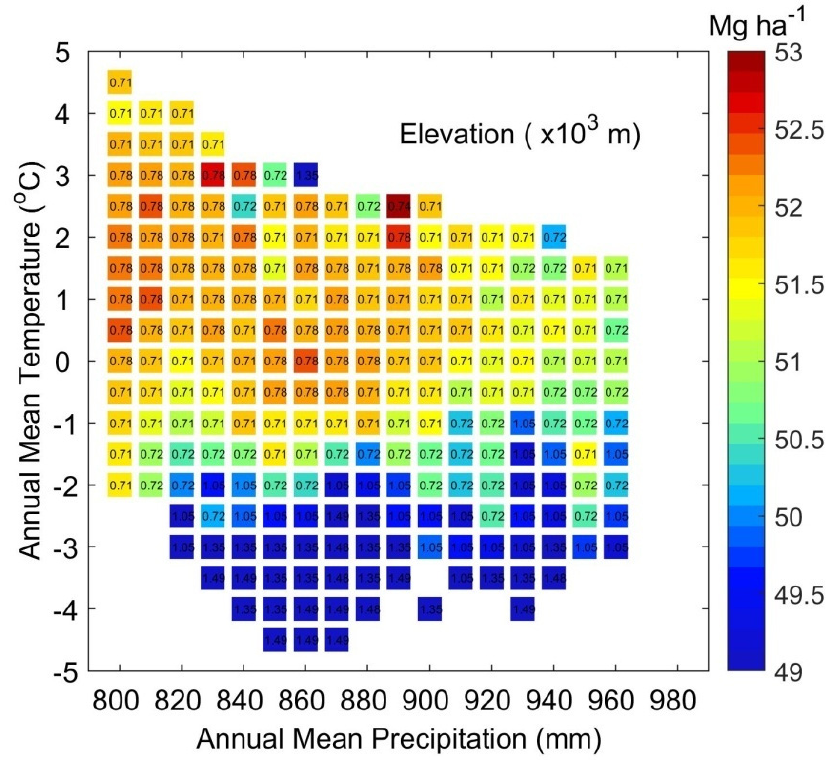
Figure 5. The spatial distribution trend of forest AGB under the combined influence of annual average temperature, annual average precipitation, and altitude gradient in the study area.